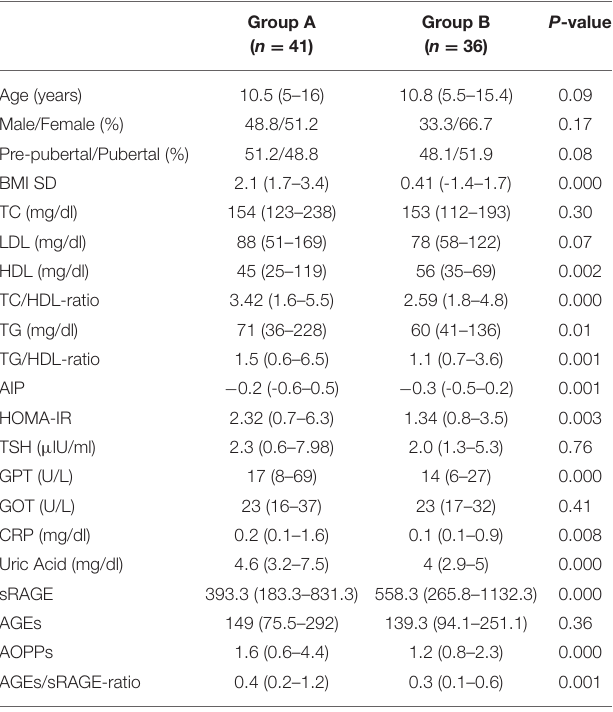
TABLE 1 | Comparison analysis of clinical data and cardio-metabolic risk factors between